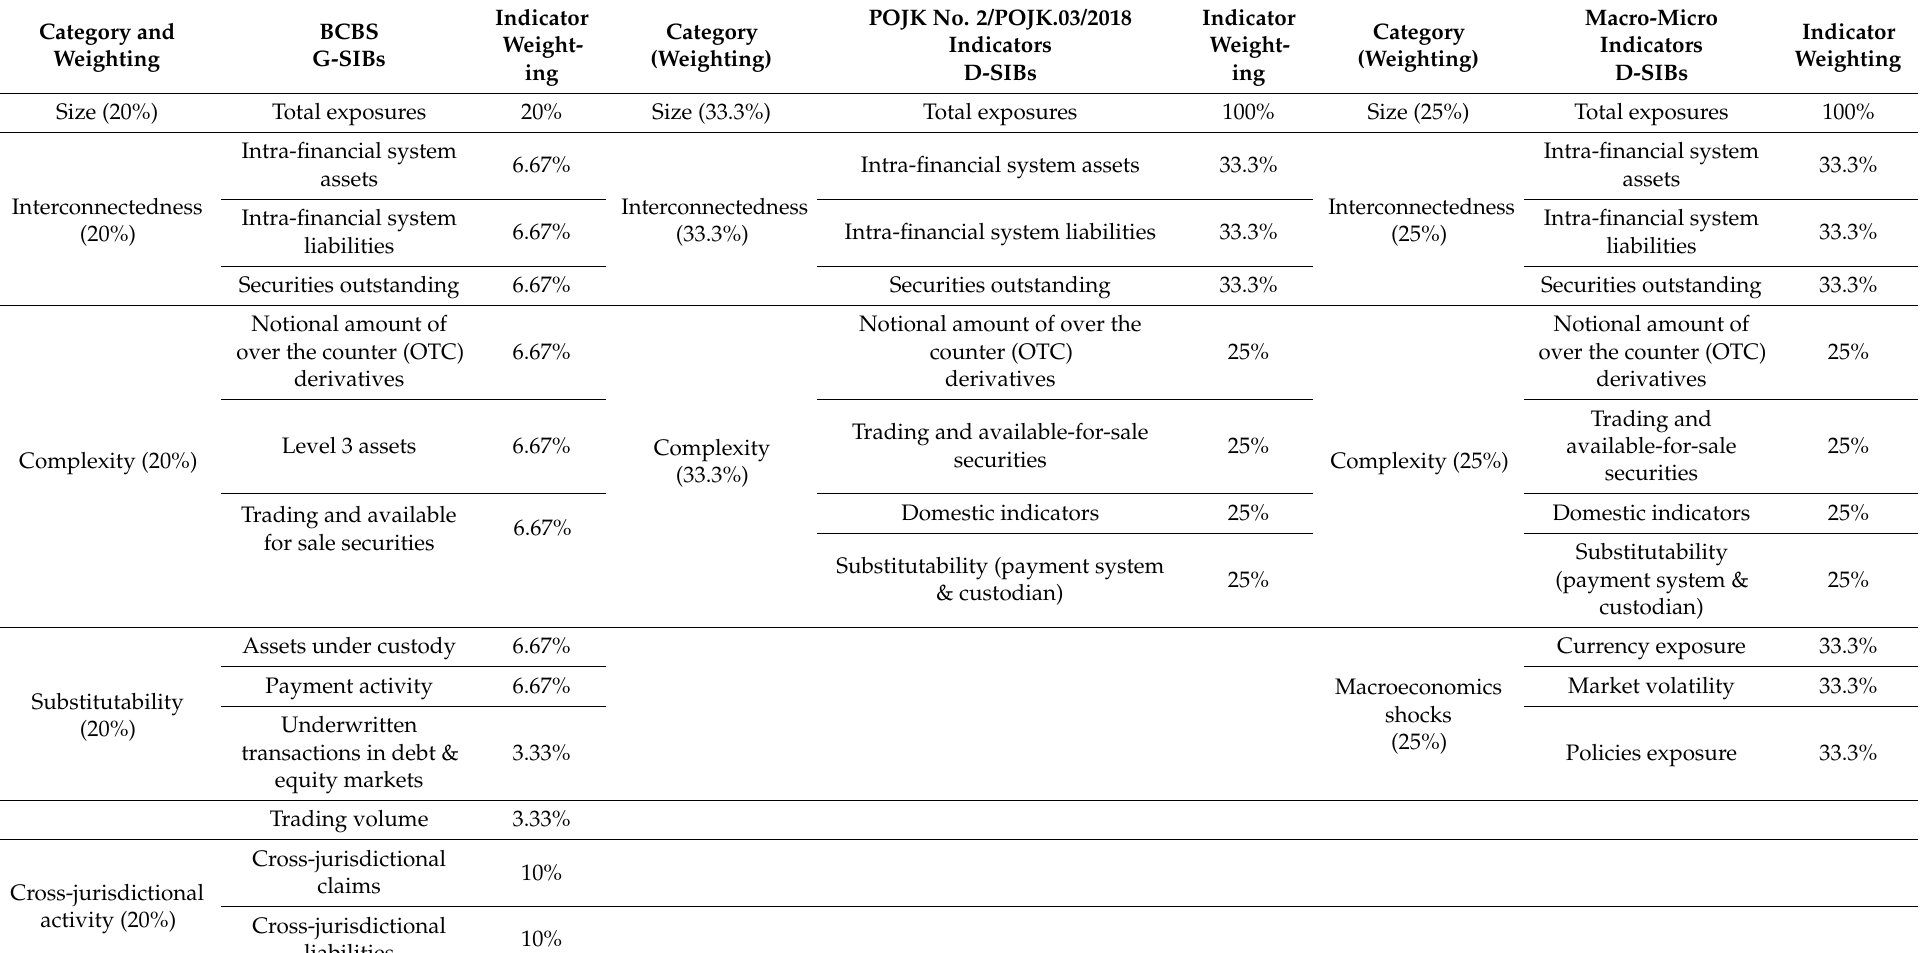
Table 15. SIBs Technical